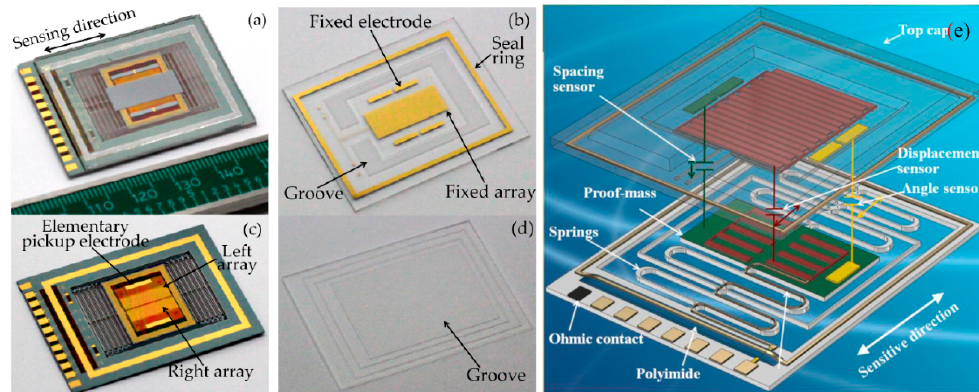
Figure 8. Images of the MEMS accelerometer developed by Wu et al . at Huazhong University of Science and Technology [39]: ( a ) assembled MEMS accelerometer; ( b ) top cap; ( c ) suspended proof-mass; ( d ) bottom cap; ( e ) schematic drawing of the MEMS accelerometer.